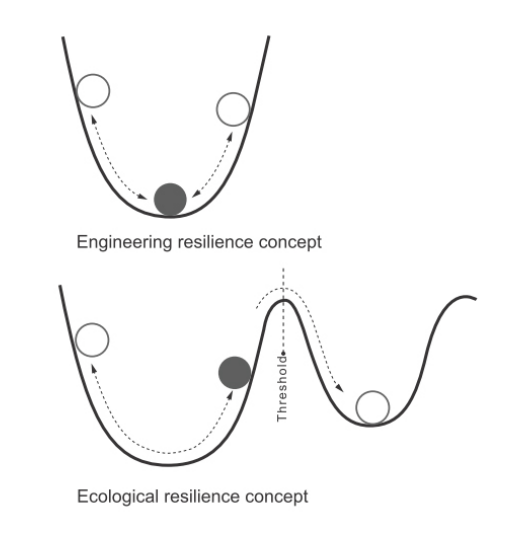
Fig. 2 . The paradigmatic difference between engineering and ecological resilience can be illustrated by the ball-and- cup heuristic (Scheffer et al. 1993, Walker et al. 2004). The cup represents the region in the state space or "basin of attraction", in which the system tends to remain, and includes all possible values of system variables of